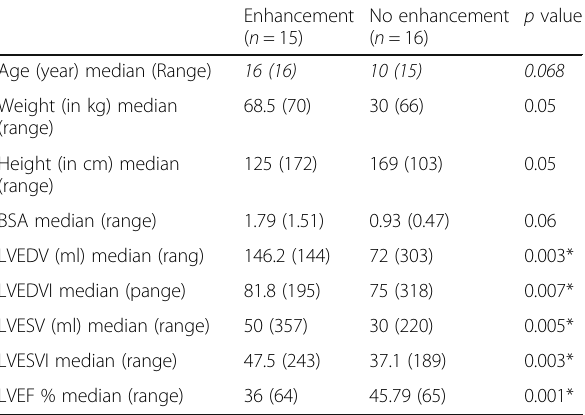
Table 5 Comparison between demographic and functional MRI findings of all studied groups between enhancement and non- enhancement groups using Mann-Whitney test